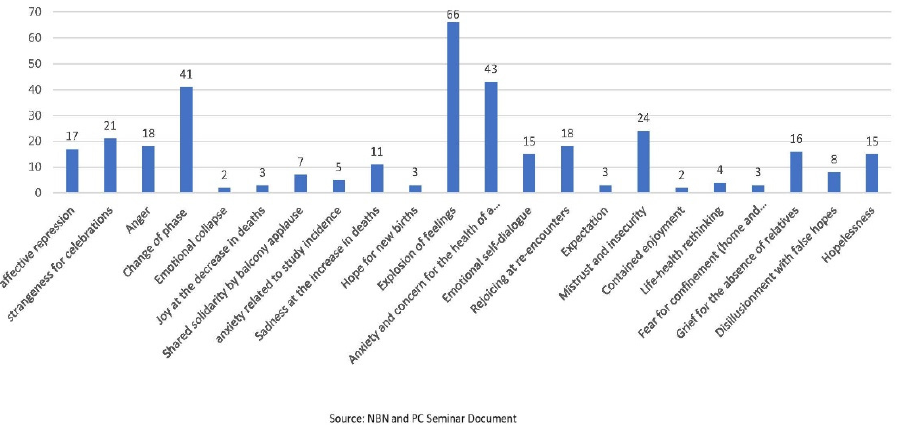
Figure 2. Feelings during the most significant day of